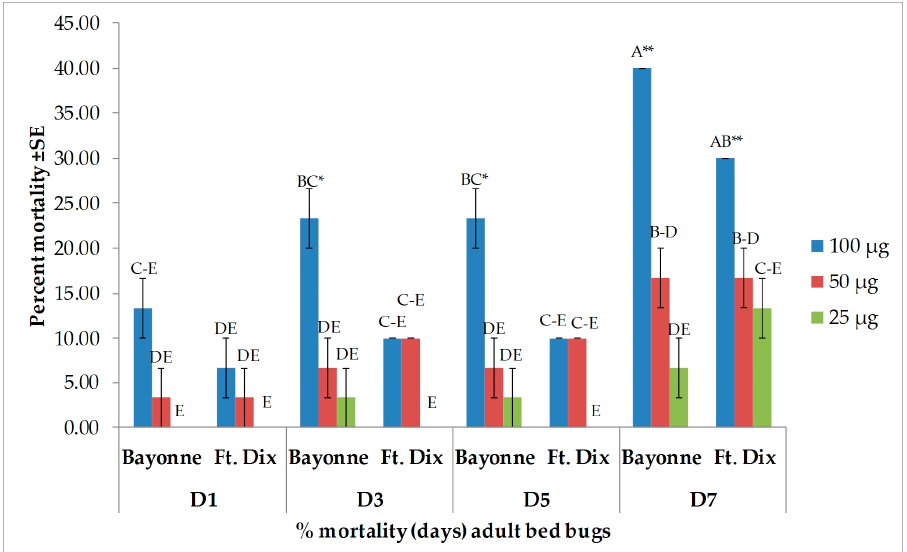
Figure 6. Mean ( ± SE) mortality produced by topical application of β -pinene on two strains of bed bug. Levels not connected by same letter are significantly different. There were three replications per treatment with 10 bed bugs per replication (Three-Factor ANOVA, p < 0.05, mean separated by Tukey’s HSD Test; JMP ® 10.0). Deltamethrin (2.4 ng, positive control) had killed 36.6% ± 3.33% (Bayonne) and 100% (Ft. Dix) at 24 h post treatment. The mortality in the Bayonne strain increased to 43.3% ± 8.82% from days 3 to 7. * Although the highest dose (100) induced higher mortality in the Bayonne strain than in the Ft. Dix strain on days 3, 5, and 7, ** this remained statistically non-significant.